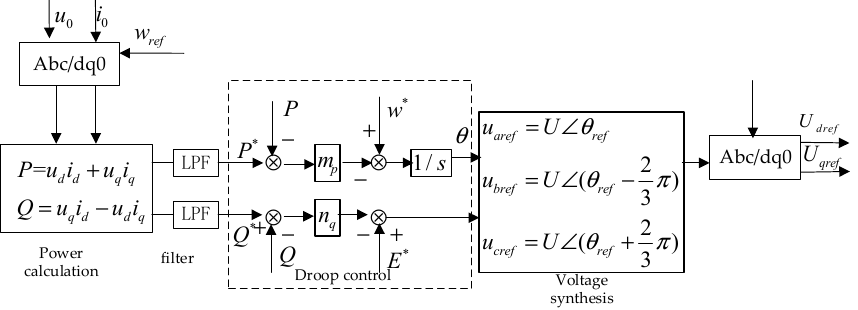
Figure 2. Traditional droop power control structure.